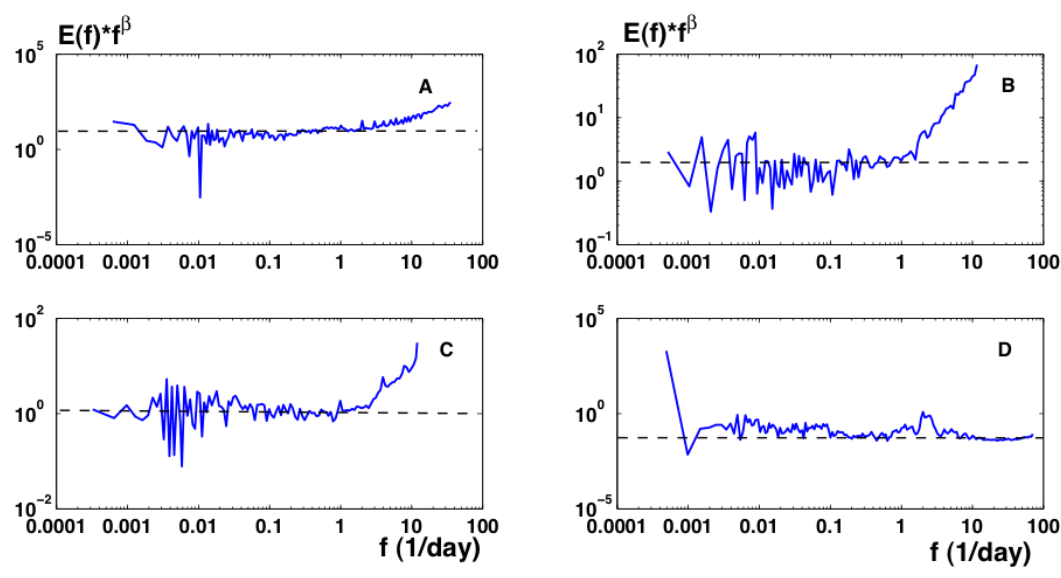
Fig. 8. Compensated spectra f β E(f ) for pH data with β estimated by regression. (A) Carnot; (B) Grande rade; (C) La Carosse and (D) Honfleur. Flat zones indicate the range of values for which the scaling is